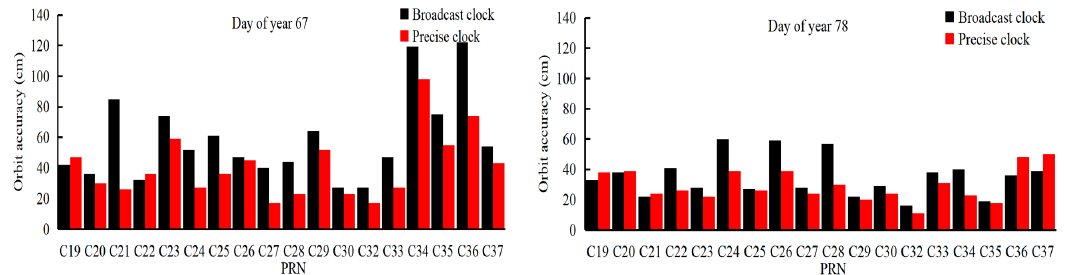
Figure 12. The daily accuracy of the BDS-2/BDS-3 rapid orbit of each satellite obtained from two types of clock offsets, and from the B1C and B2a observations, on DOYs 67 ( left ) and 78 ( right ).